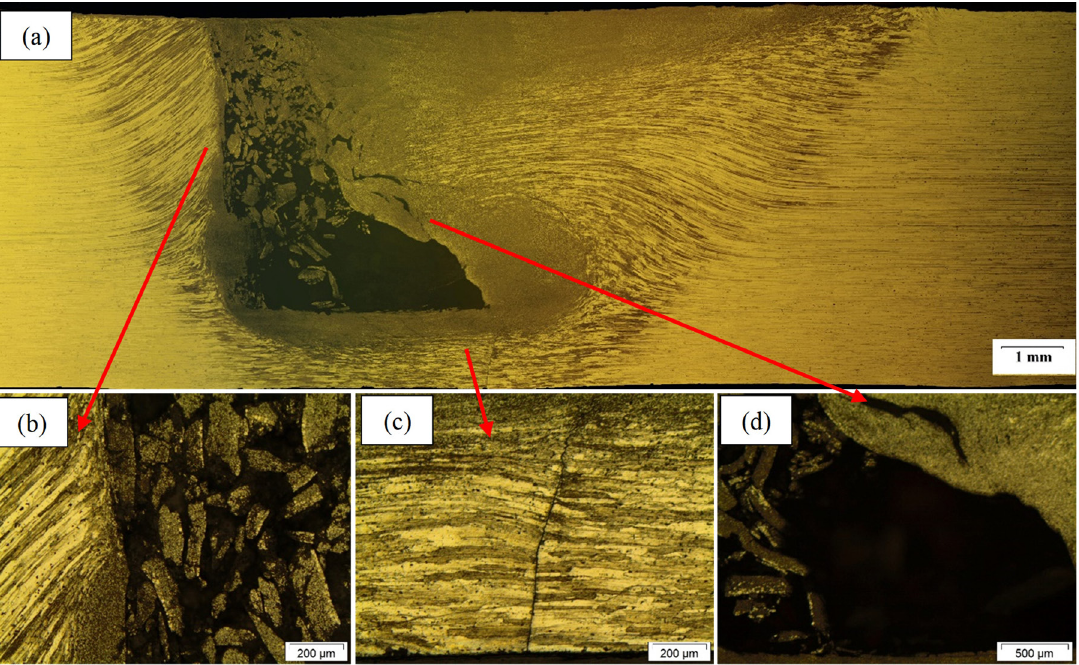
Figure 9. Macro and microstructure of the welded joint 4: (a) Macrograph of the cross section, (b) Micrograph of the region between TMAZ and SZ on the retreating side observing lack of mixture, (d) welding defect due to lack of union, and (c) welding defect in the SZ on the retreating side due to lack of